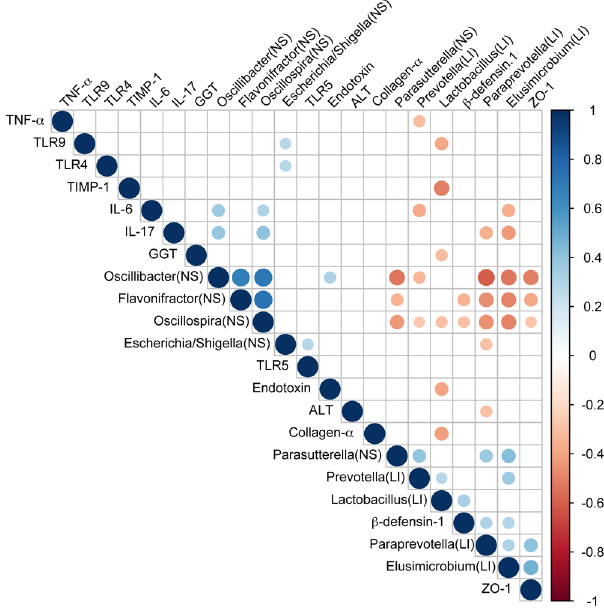
Figure 6. Gut microbiota changes are closely associated with the level of endotoxin, inflammatory cytokines, profibrogeneic genes and gut barrier marker. Heatmap of Spearman’s rank correlation cofficients of the relative abundances of alternation-related bacteria with inflammatory cytokines, profibrogeneic genes and gut barrier marker in all cirrhotic rats. The letters NS in parentheses on the heatmap indicates the microbiota was enriched in NS group; the letter LI in parentheses on the heatmap indicated the microbiota was enriched in LI01 and LI05 group. Those correlations with a coefficient r < 0.25 are deleted and not shown in this figure. Color key and circle size indicates the strength of correlation (r value). Dark blue indicates a more positive correlation; dark red indicates a more negative correlation; white indicates no